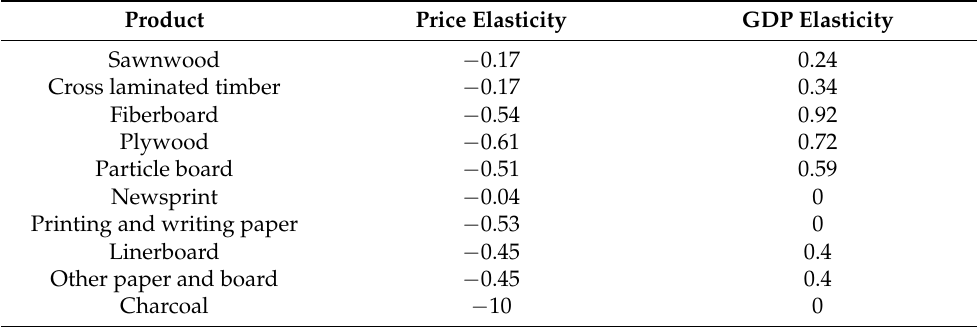
Table 2. Price and GDP elasticity for the various end products. Source: [66].